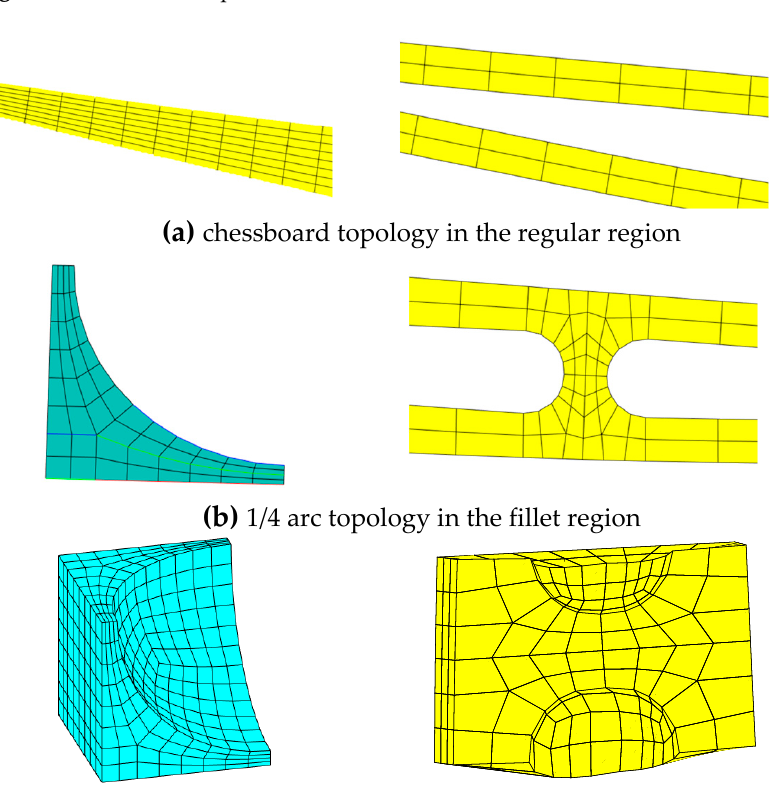
Figure 5. FEM topologies in the different regions.